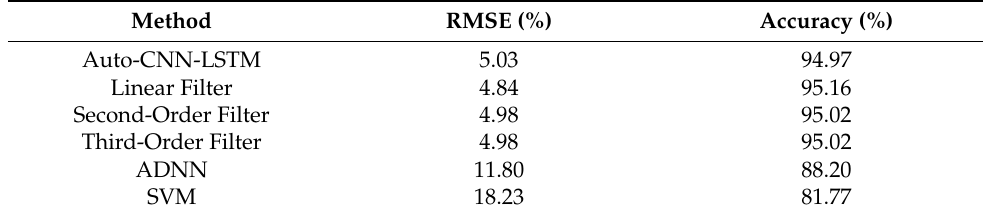
Table 7. Results of the